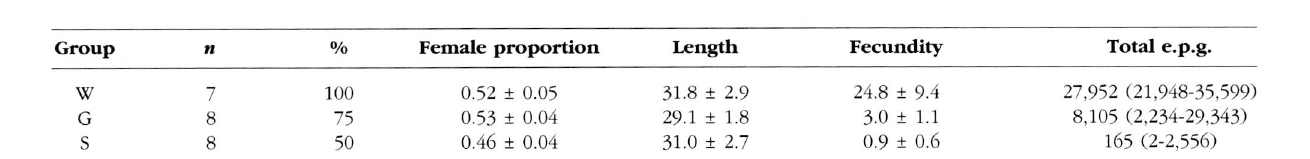
Table II. - Prevalence (%) of infection (no. of infected/no. of pigs), proportion of female T. suis, worm length (mm), worm fecundity (e.p.g./no. of female T. suis) in sows (S), weaner (W) and grower (G) pigs at necropsy 10 weeks p.i. (mean ± S.D). Geometric mean (95 % confi­ dence interval) total egg excretion from week six to 10 p.i.